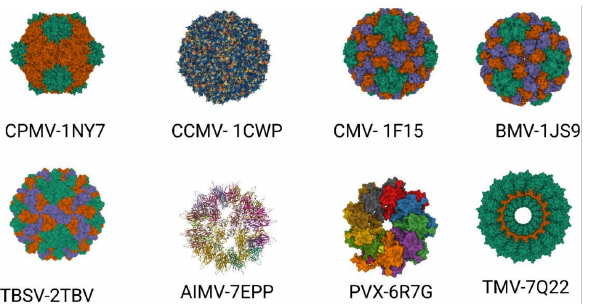
Figure 2. Important plant VLPs with application in biotechnology and plant viral-based nanotechnol- ogy. Plant viruses with their corresponding protein databank identification number—CPMV (PDB ID: 1NY7), CCMV (PDB ID: 1CW7), CMV (PDB ID: 1F15), BMV (PDB ID: 1JS9), TBSV (PDB ID: 2TBV), AIMV (PDB ID: 7EPP), PVX (PDB ID: 6R7G), TMV (PDB ID: